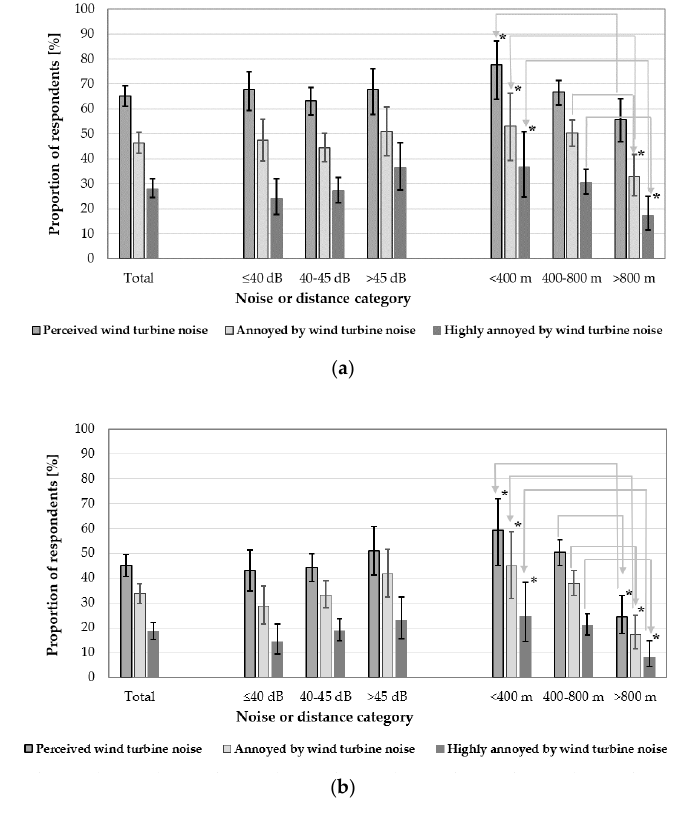
Figure 4. Comparison of proportions (with 95% confidence intervals) of respondents who perceived and were annoyed or highly annoyed by the turbine noise ( a ) outdoors and ( b ) indoors in total and in each of the noise and distance categories. Significant differences between distance categories are marked (*) ( p < 0.0167).